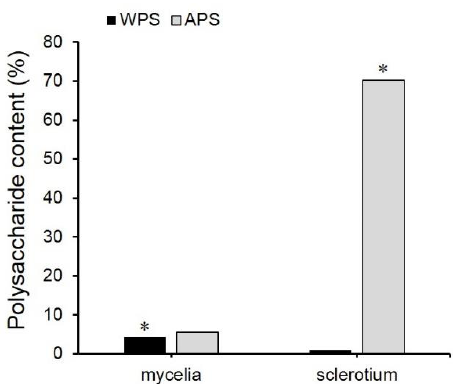
Figure 1. Comparison of the polysaccharide contents (%) in fermented mycelia and cultivated sclerotium of P. cocos . Notes: WPS: water-soluble polysaccharides; APS: alkali-soluble polysaccharides; %: g / 100 g dry weight. Asterisks indicated the significance ( p < 0.01).